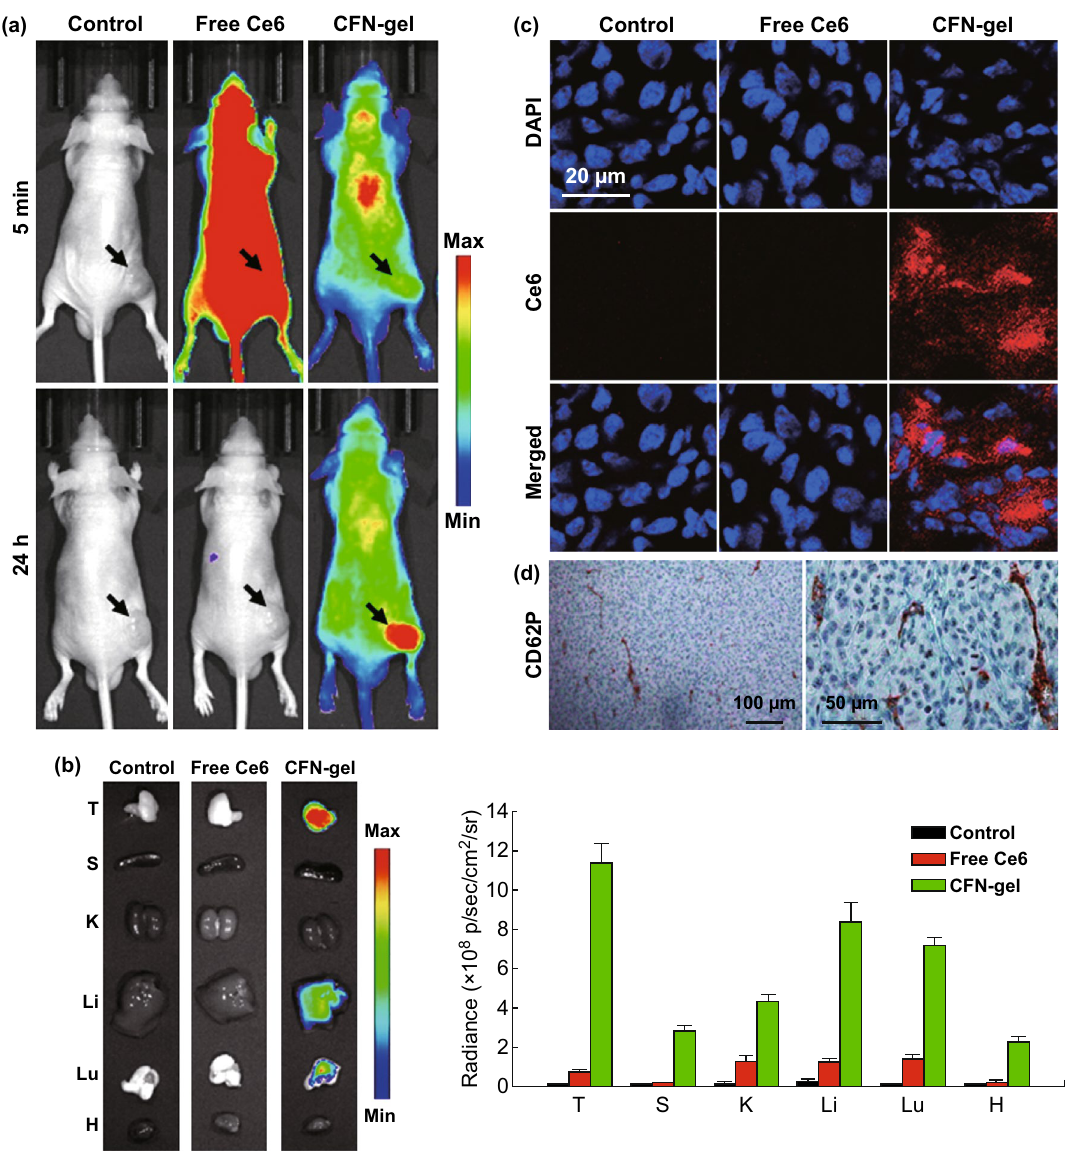
Fig. 6 In vivo evaluation of selective tumor imaging in xenograft tumor models. a NIR fluorescence images of PBS‑, free Ce6‑ or CFN‑gel‑ treated mice. After 5 min and 24 h of intravenous injection of PBS (100 μL), free Ce6 (5 mg Ce6 kg −1 ) or a CFN‑gel (5 mg Ce6 equiv. kg −1 ), NIR fluorescence images of the HT1080 tumor‑bearing mice were obtained ( λ ex = 660/20 nm, λ em = 710/40 nm), b left: ex vivo NIR fluorescence images of the tumors and major organs (T: tumor, S: spleen, K: kidney, Li: liver, Lu: lung, H: heart) at 24 post‑injection. Right: quantitative anal‑ ysis comparison of fluorescent intensity in the tissues ( n = 3 per group), c confocal fluorescence microscopic images of tumor sections prepared 24 h post‑injection. Nuclei in the tumor sections were stained using DAPI. The fluorescence of DAPI ( λ ex = 405 nm, λ em = 420–480 nm) and Ce6 ( λ ex = 633 nm, λ em = 647–754 nm) were pseudocolored in blue and red, respectively, d immunohistochemical staining images of CD62P expres‑ sion (i.e., P‑selectin) in the tumor sections. (Color figure